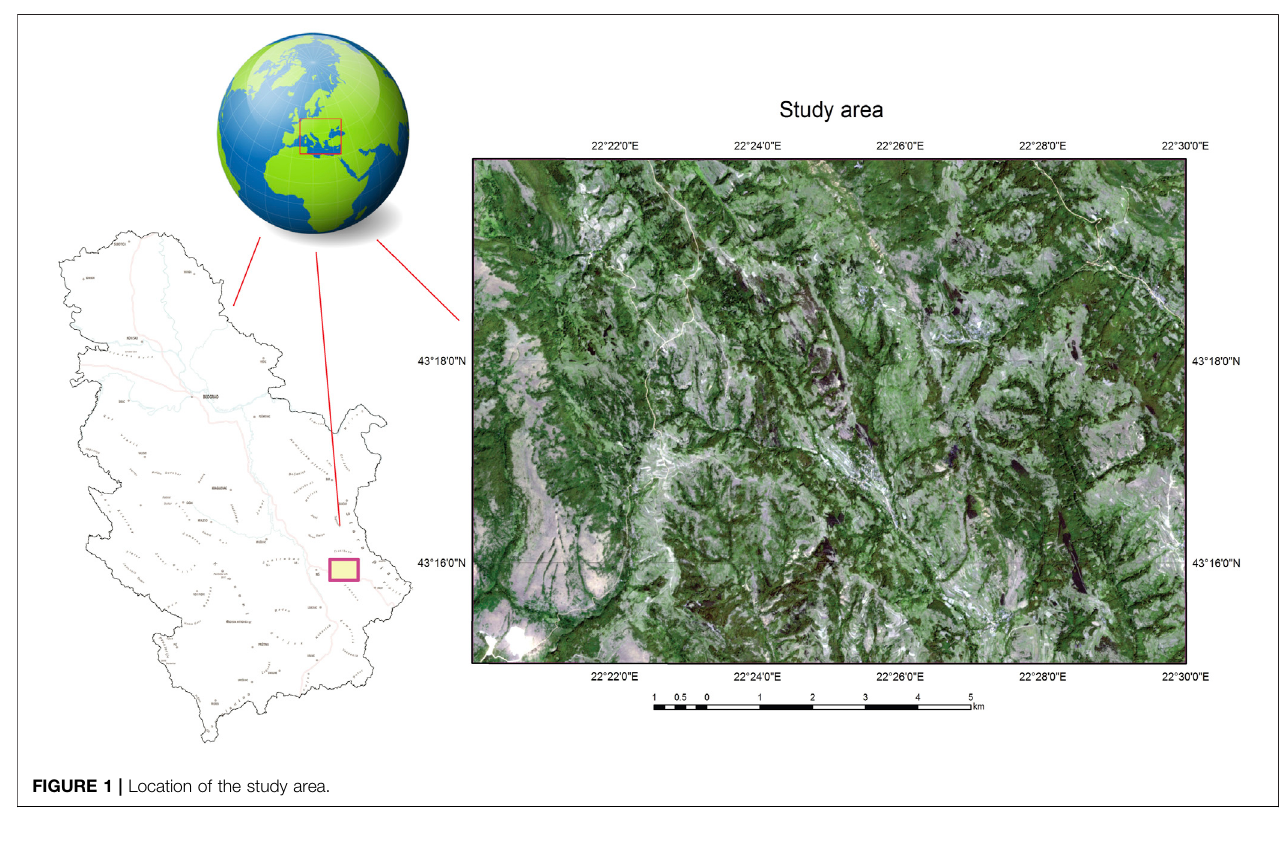
FIGURE 1 | Location of the study area.